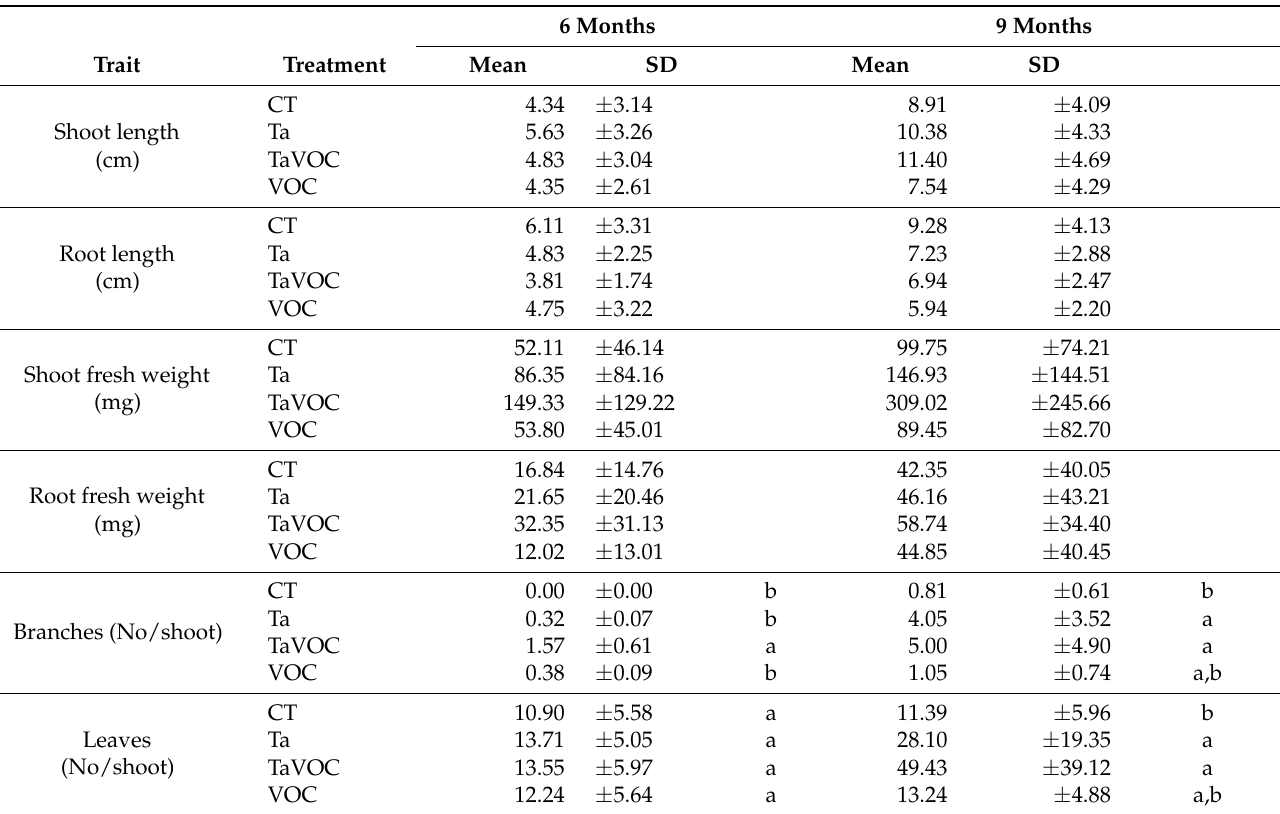
Table 1. Effects of Terfezia arenaria inoculum and 1-octen-3-ol on Cistus salviifolius plant traits: shoot length (SL), shoot weight (SW), root length (RL), root weight (RW), number of lateral shoots and number of leaves observed six and nine months after the inoculation. (N = 6 per treatment). Treat- ments: CT—control; VOC—1-octen-3-ol 1 µ M; Ta— Terfezia arenaria inoculum; TaVOC— T. arenaria inoculum and 1-octen-3-ol 1 µ